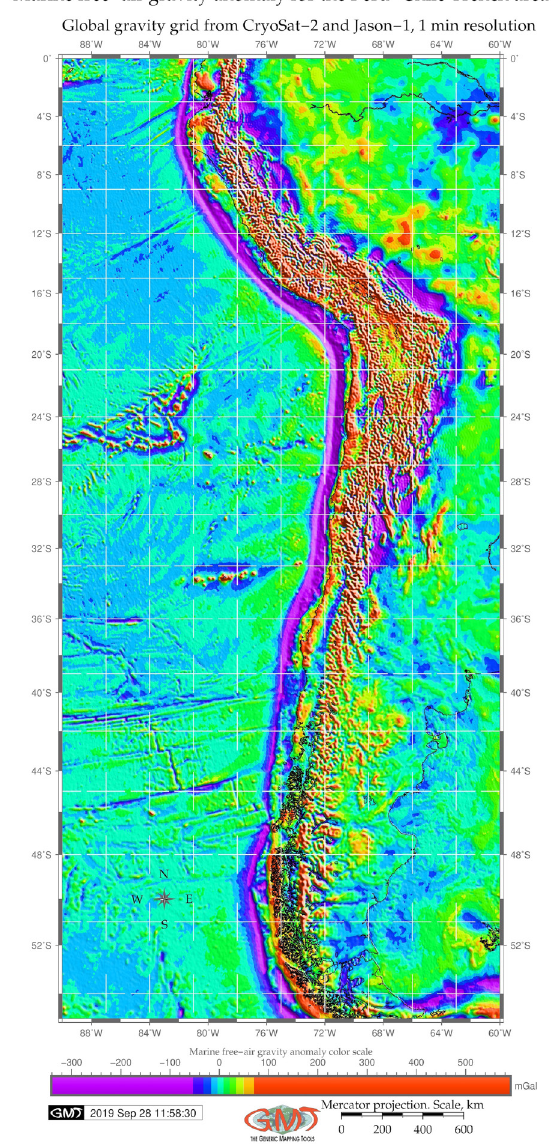
Fig. 4. Gravimetry model map of the Peru-Chile Trench